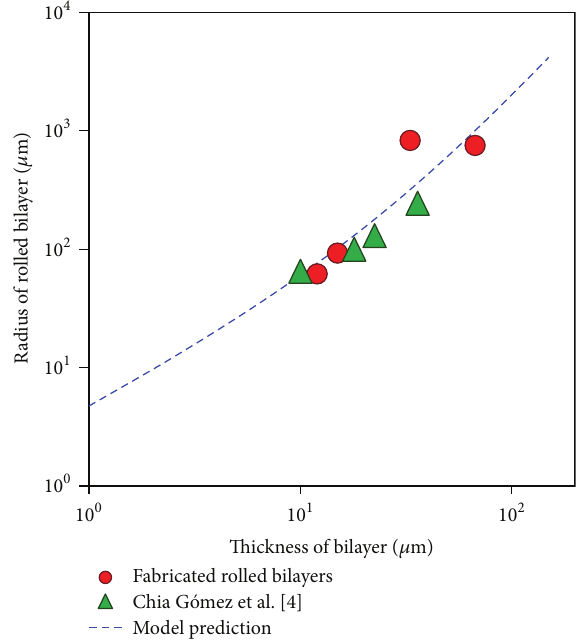
Figure 3: A plot of the radius of rolled bilayer as a function of the bilayer thickness. Radii in the plot are either measured from the rolled bilayer fabricated in this study (red circles), obtained from the previous literature (green triangles) [4], or predicted from Timoshenko’s model (blue dashed